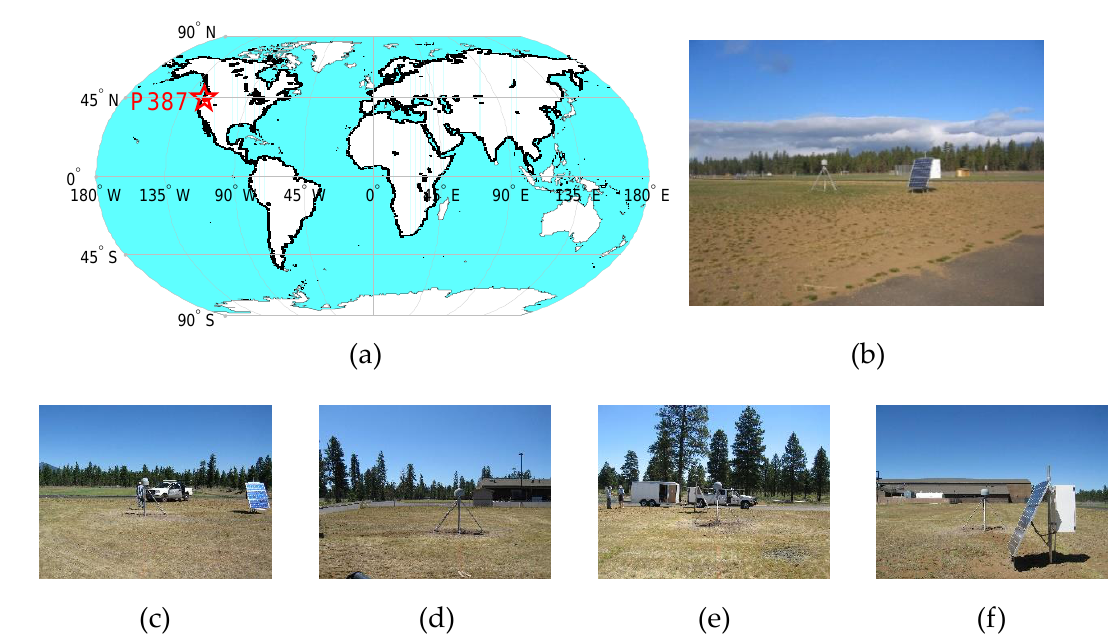
Figure 2. P387 station conditions: ( a ) station location in the world; ( b ) site vision; ( c ) site north; ( d ) site south; ( e ) site east; ( f ) site west.